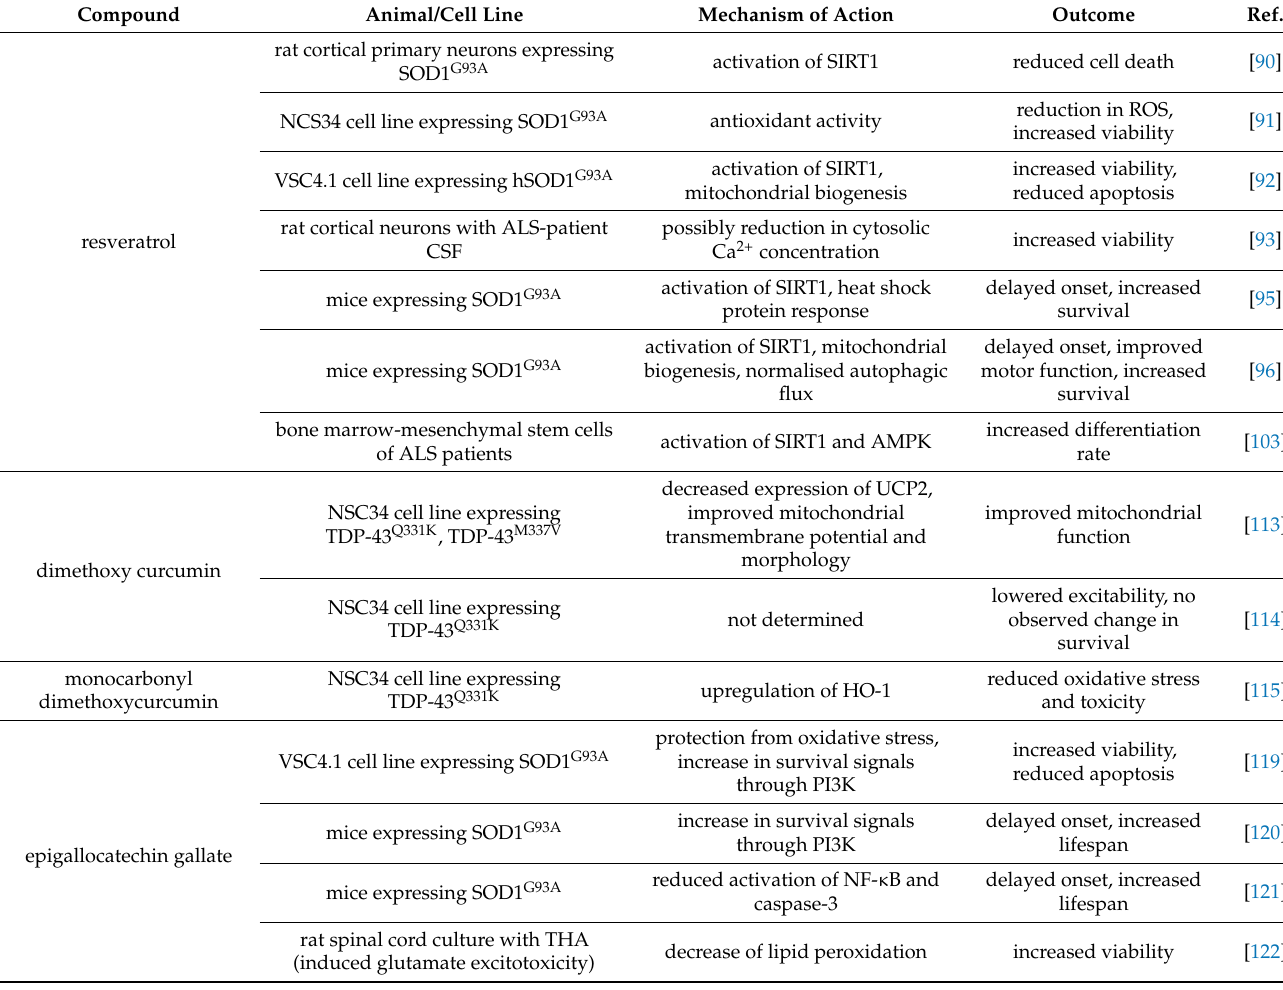
Table 1. Therapeutic implications of different polyphenols in ALS and FTD